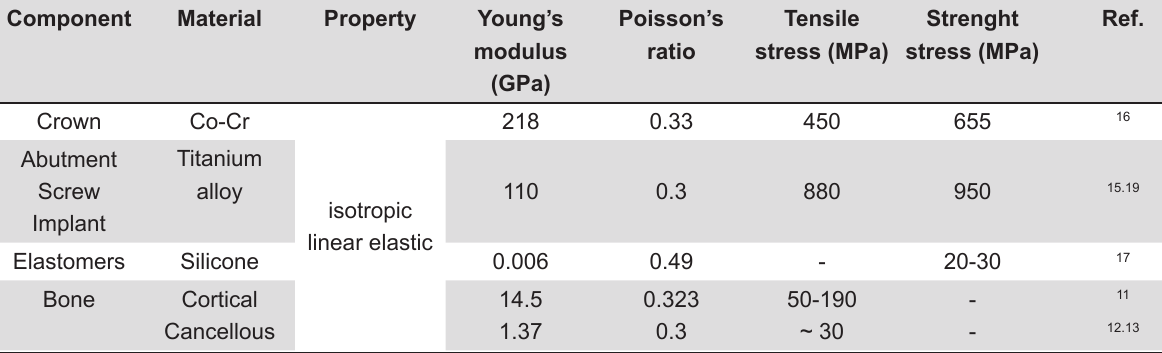
Table 2- Mechanical properties of implant model components Component